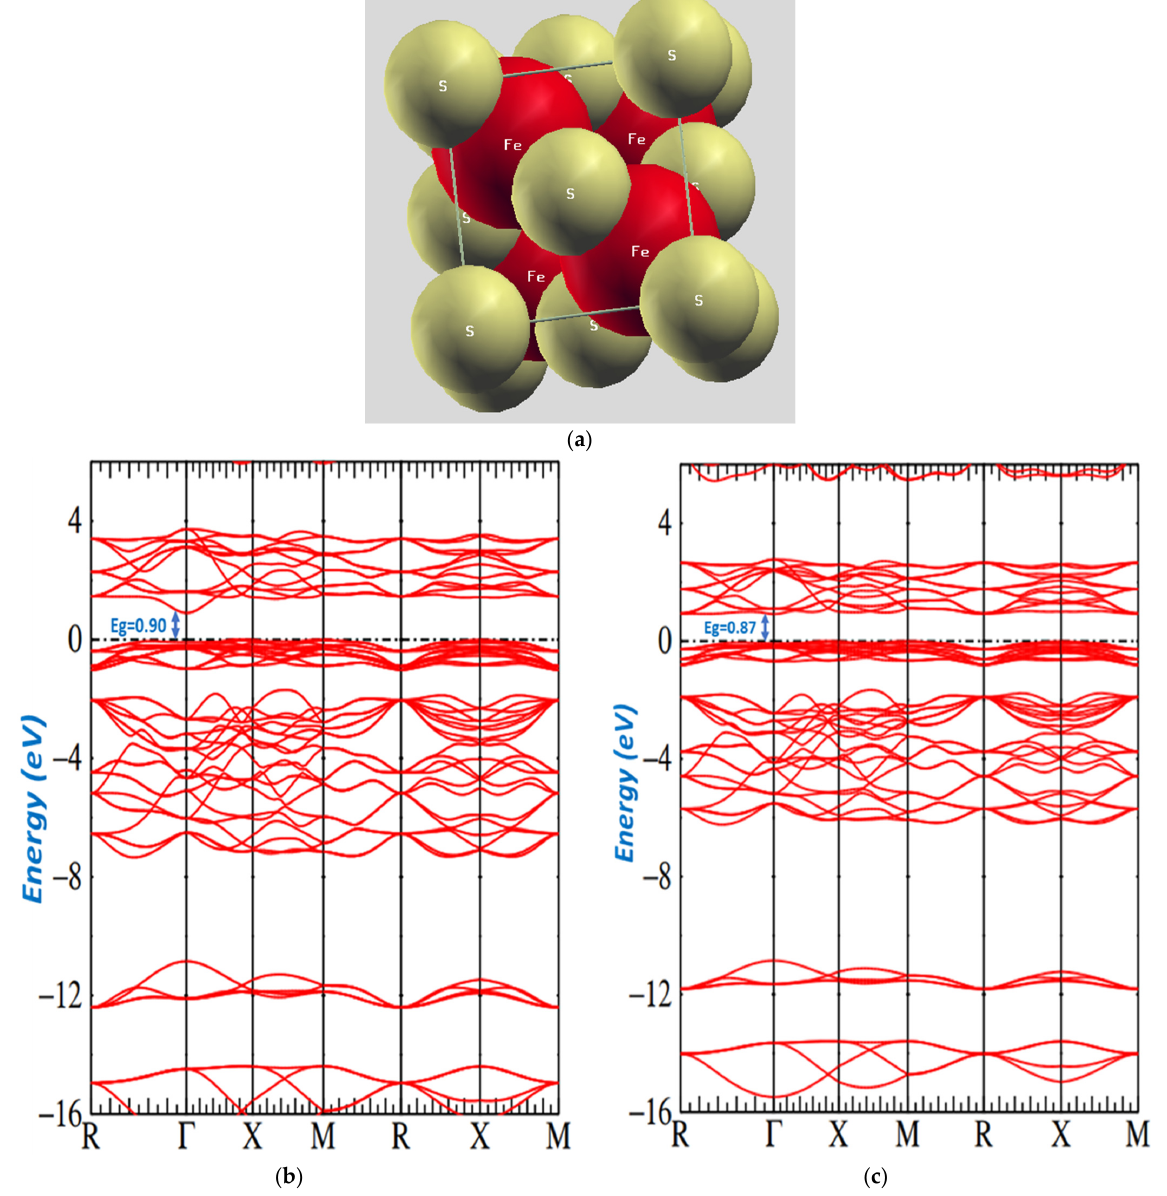
Figure 5. ( a ): Image of overlap of 𝐹𝑒𝑆 (cid:2870) pyrite. ( b ): Band structure of 𝐹𝑒𝑆 (cid:2870) pyrite. ( c ): Band struc- ture of 𝐹𝑒𝑆 (cid:2870) pyrite at the temperature 350 °C and at the temperature 400 °C.